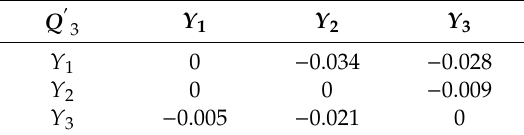
Table 20. The regret matrix Q (cid:48) 3 .